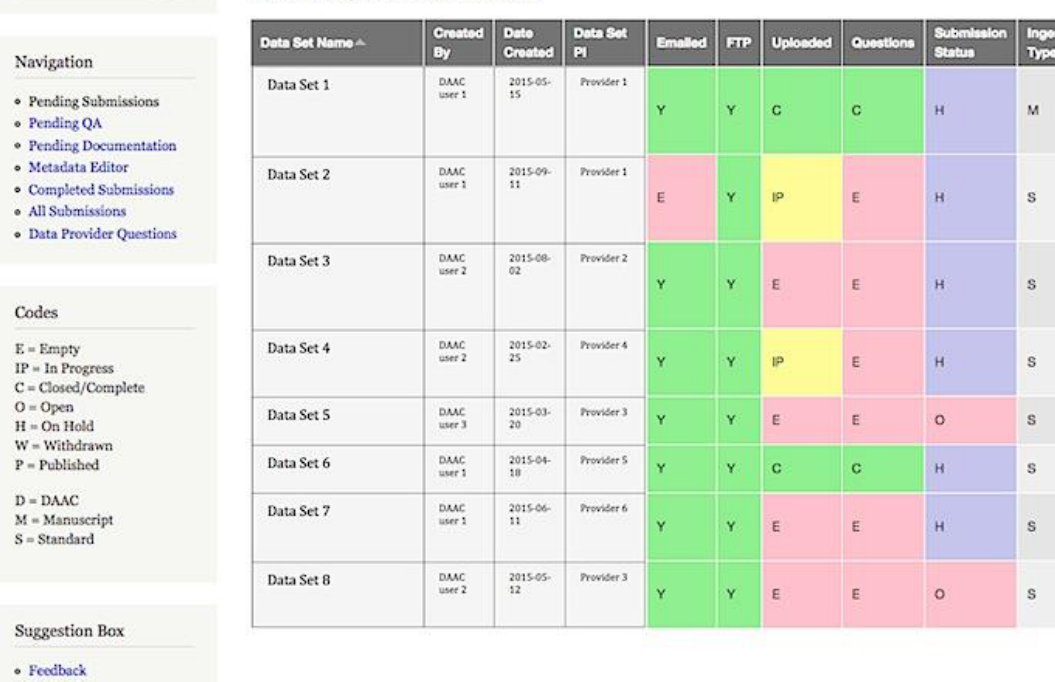
Figure 8. SAuS Ingest dashboard.